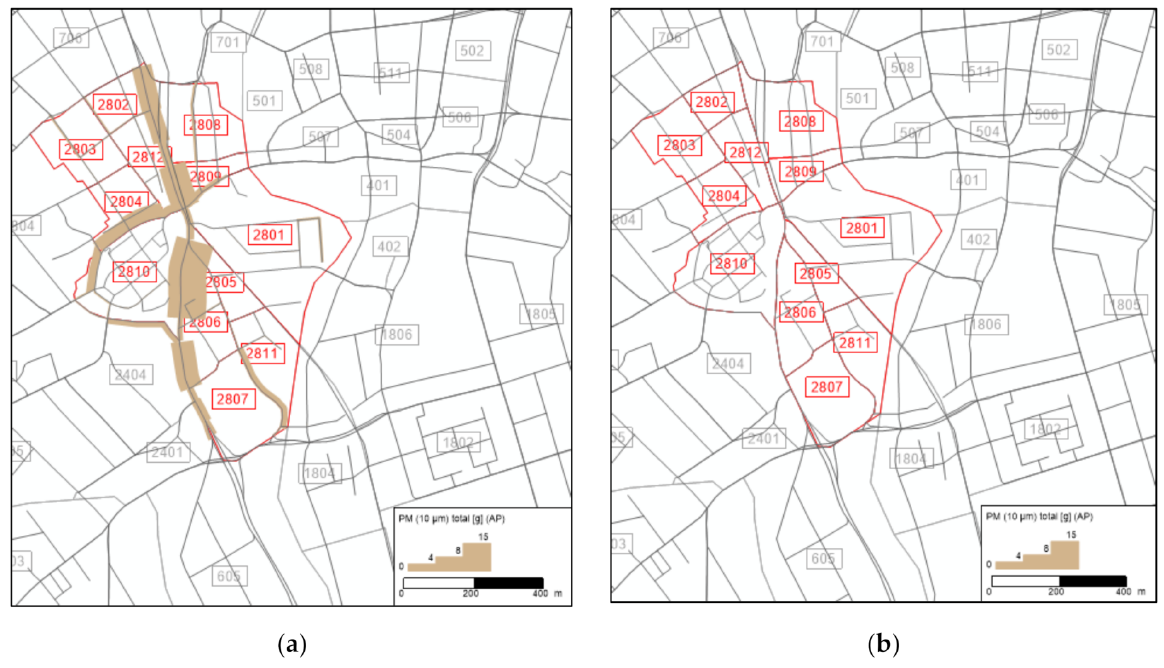
Figure 17. The assessment of PM (10 µ m) total [g] (measure from Group 1) for scenario W0 and optimal scenario (W3)— analysis for the central areas of the city: ( a ) measures for scenario W0; ( b ) measures for scenario